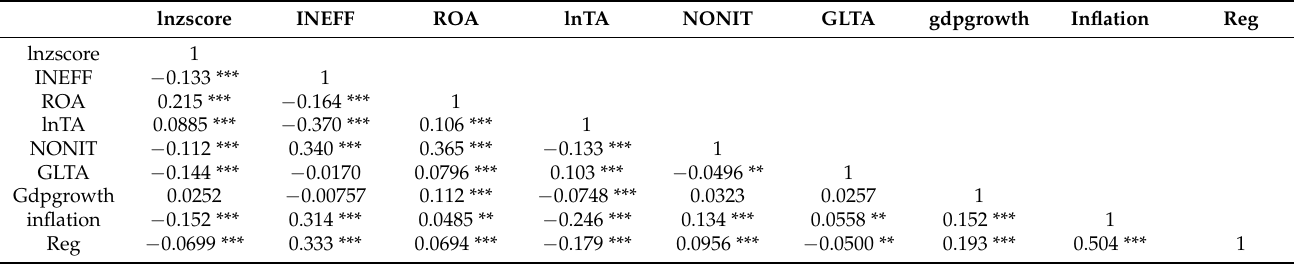
Table 7. Correlation